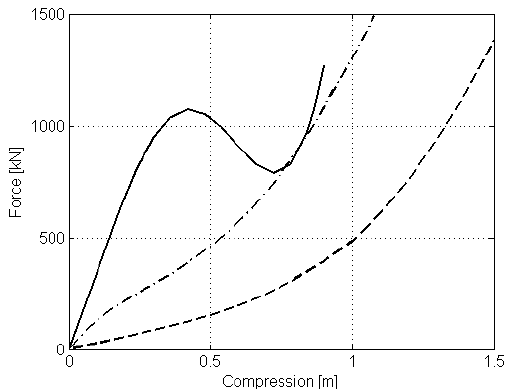
Figure 7. Fender load ‐ compression curves for Supercone fender SCN 1200 E1.1 ( ― ), Pneumatic fender 2500 × 4000 ( − − ) and airblock fender 1800 × 1800 (· − ·).